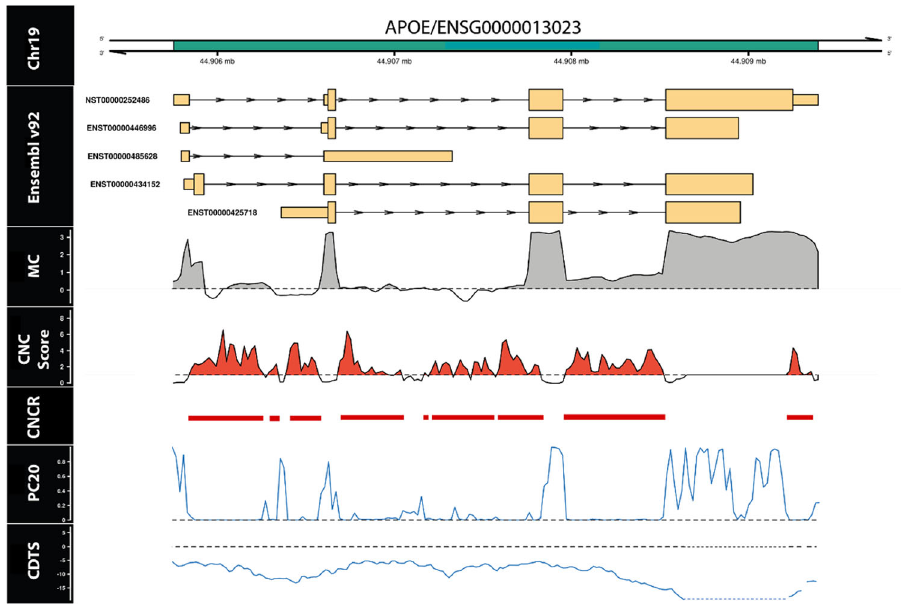
Fig. 5 Annotation with constrained, non-conserved regions (CNCRs) is highly granular and shows APOE to have a high density of CNCRs throughout its length especially in association with an intron-3 retention event in the human hippocampus. The fi rst track represents the genomic location of APOE within chromosome 19. The second track shows the known transcripts, currently within annotation in Ensembl v.92. The mean coverage (MC) (log 10 scale) in the hippocampus shown here is greater than zero (denoted by the grey shaded area) across intron-3 highlighting an intron-3 retention event (mean coverage data derived from GTEx v.7). In the fourth track, CNC scores above the black dashed line and shaded in red ful fi l criteria for a constrained, non- conserved region (CNCR) are shown. The intron-3 retention event has the highest CNCR density among all intronic regions of APOE . The fi fth track labelled “ CNCR ” depicts regions ful fi lling criteria for CNCR. PC20 represents the mean phastCons20 score. The black dashed line within this track represents a mean phastCons20 score of 0. CDTS represents the context-dependent tolerance score as a measure of constraint with the black dashed line showing a CDTS of 0. Within the CDTS track, the blue dotted line represents a region with no CDTS